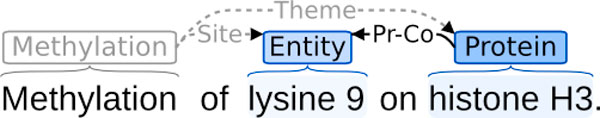
Example REL relation annotation. Simple REL annotation example showing a PROTEIN-COMPONENT (PR-CO) relation between "histone H3" and "lysine 9". An associated METHYLATION event and its arguments (shaded, not part of the REL task targets) shown for context.